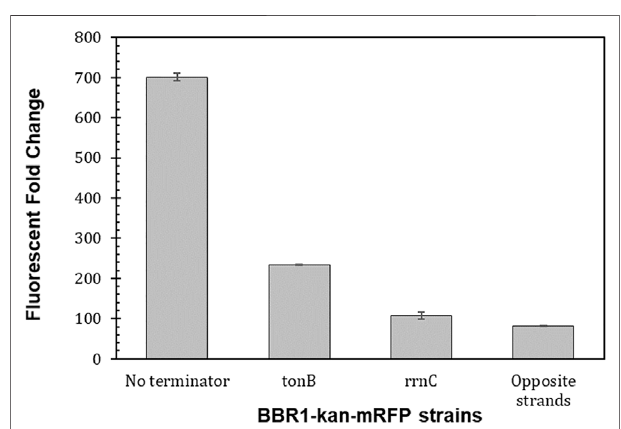
FIGURE 6 | Transcriptional terminators reduce read-through from the preceding transcription unit. Fluorescent fold change average of R. palustris BBR1-kan-mRFP (no terminator), BBR1-kan-mRFP-tonB, BBR1-kan mRFP rrnC, and BBR1-kan-mRFP (opposite strand) strains grown in triplicate (Materials and Methods). Error bars represent the population standard